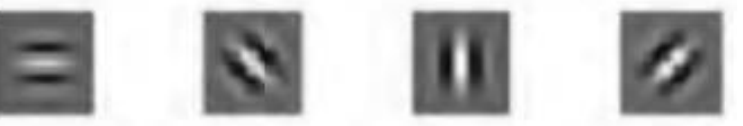
Figure 4. Gabor filter with different orientations (0 ◦ , 45 ◦ , 90 ◦ , 135 ◦ ) for MRI images. Bottom-up saliency maps are obtained by taking the geometric mean of the feature maps.